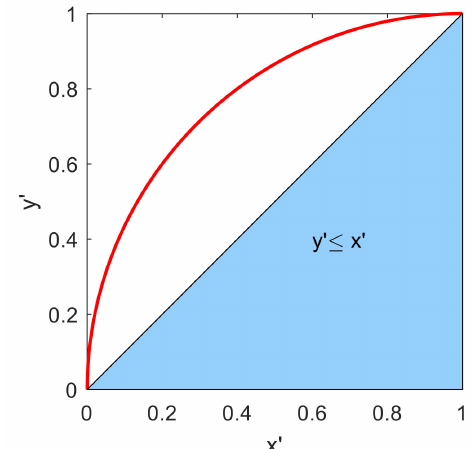
− t − t ≥ T T 1 , and hence T T 2 ≤ e 2 . 1